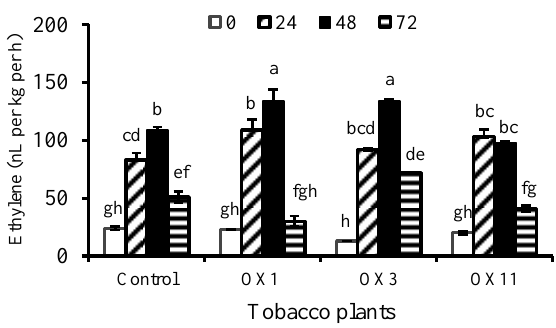
Figure 5. Temporal changes in ethylene production by detached Nicotiana tabacum flowers from control, and different PI3K-over expressed (OX) transgenic lines. Flowers selected at stage 5 were stored for 72 h after detachment from plants and the rate of ethylene production was determined every 24 h. Data shown are mean ± SE for a total of n = 7–10 flowers from three biological replicates. ANOVA was performed on data, and significant ( p < 0.05) differences between means were determined using Duncan test. Statistical significance among means is denoted by different letters (a–g).